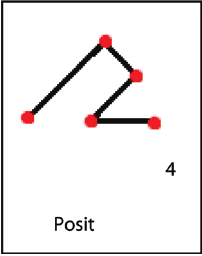
Figure 6. Pattern for “Posit.”